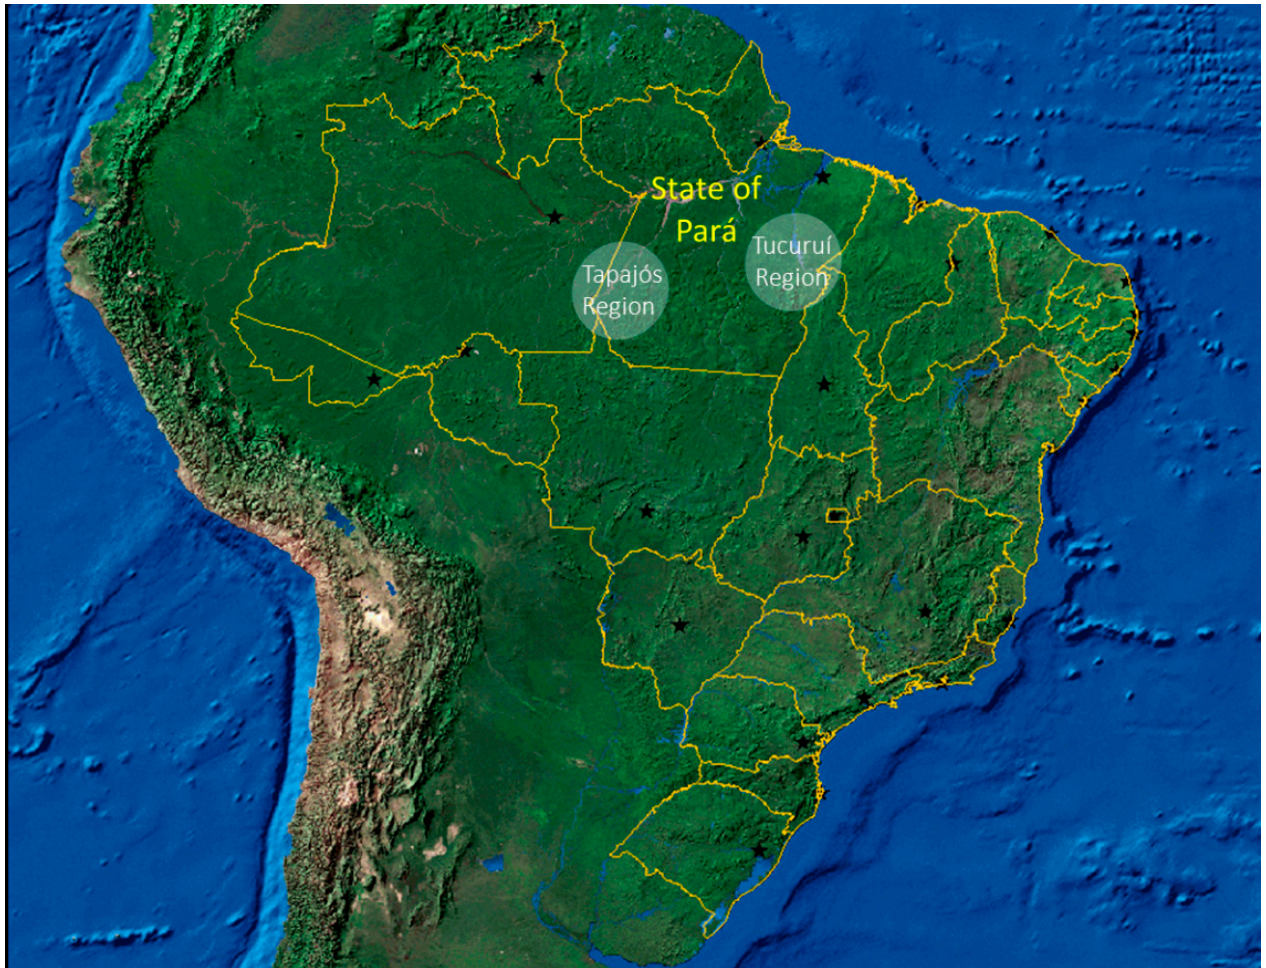
Figure 1. Map of Brazil showing the states (yellow lines) and their capitals (black stars). The two regions included in this study are indicated in white. Adapted from maps available at https://www.ibge.gov.br/geociencias/cartas-e-mapas/mapas-de-referencia.html (accessed on 12 February 2021).